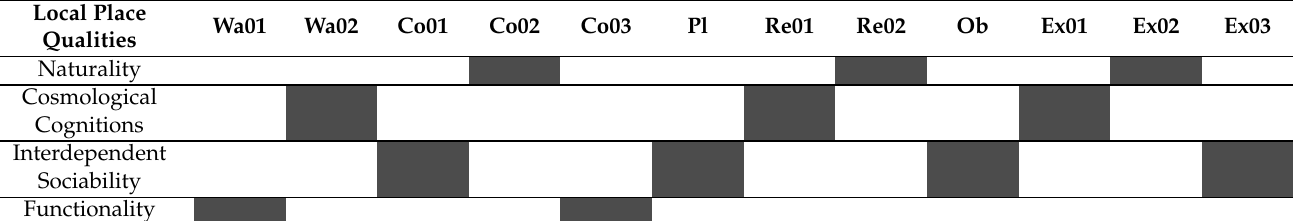
Table 5. Local cognitions-based behaviours in relation to design qualities of spaces. The dark grey color indicates each local cognition based behaviour with relevant local place